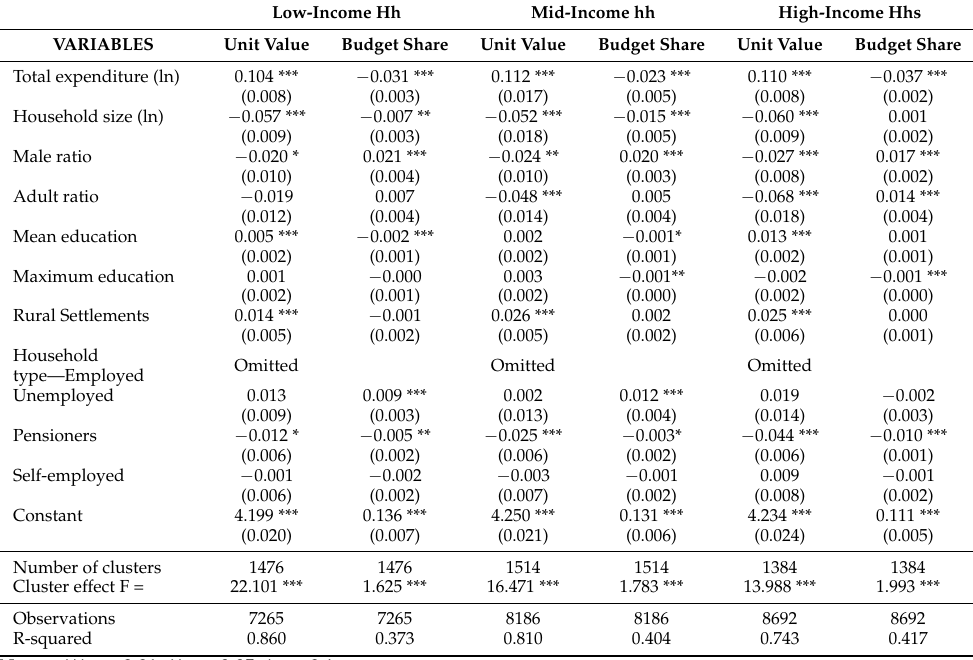
Table A5. Unit value and budget share equations from Deaton model by income